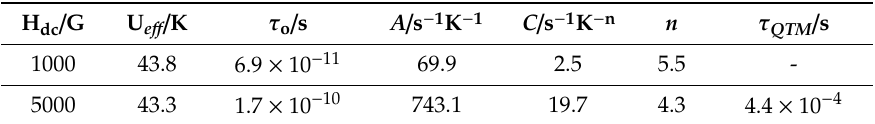
Table 3. Parameters of the magnetic relaxation obtained through the dc applied magnetic fields of 1000 and 5000 G and the Equation (2) for 1 .